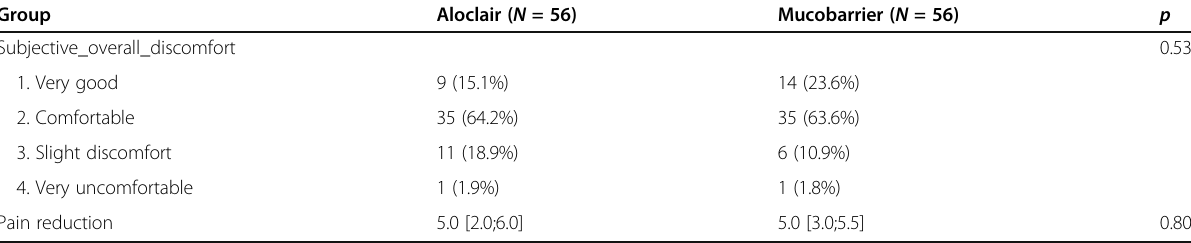
Table 2 Post-operative discomfort and pain Group